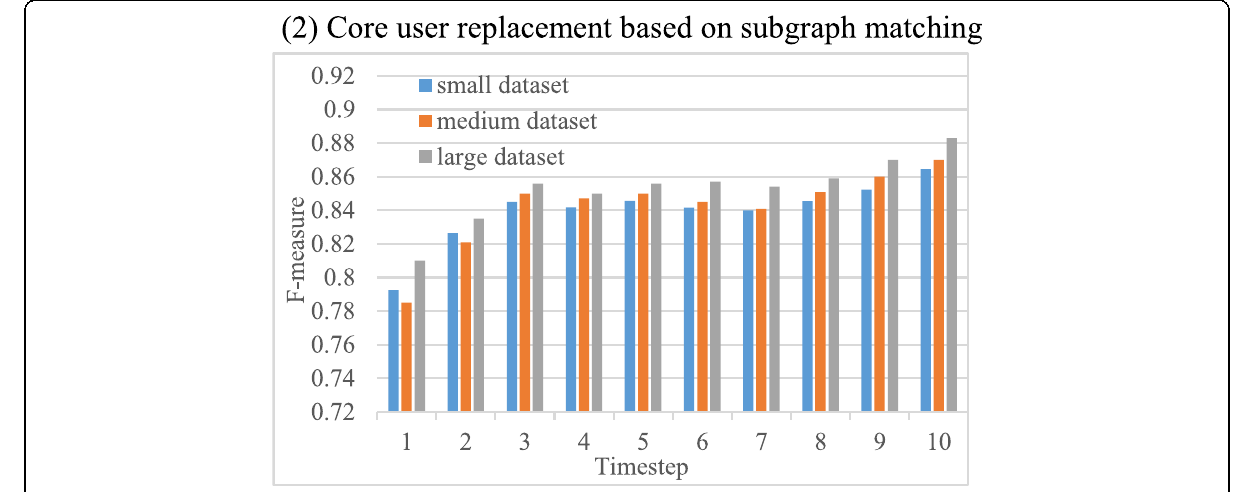
Fig. 10 F-measure values comparison on different